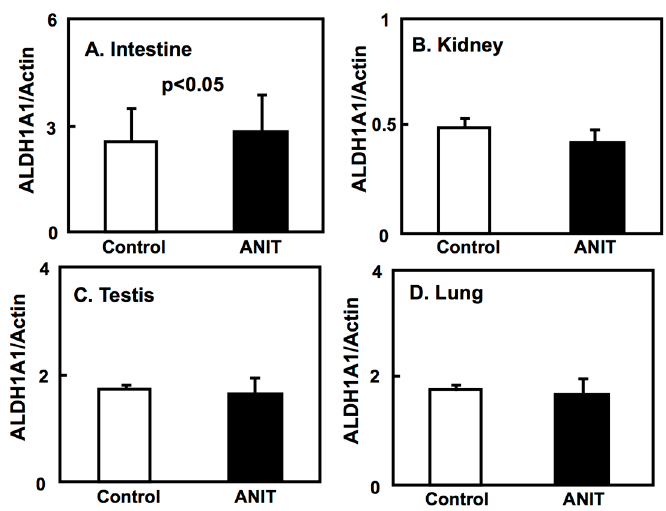
Figure 8. Tissue-specific expression of ALDH1A1 in control and ANIT rats. The mRNA levels of the ALDH1A1 gene of several tissues including intestine ( A ), kidney ( B ), testis ( C ), and lung ( D ) in both groups ( n = 5 for each group) were examined by quantitative real-time PCR. Each bar represents the mean value ± SD and significant differences are indicated in the graph.